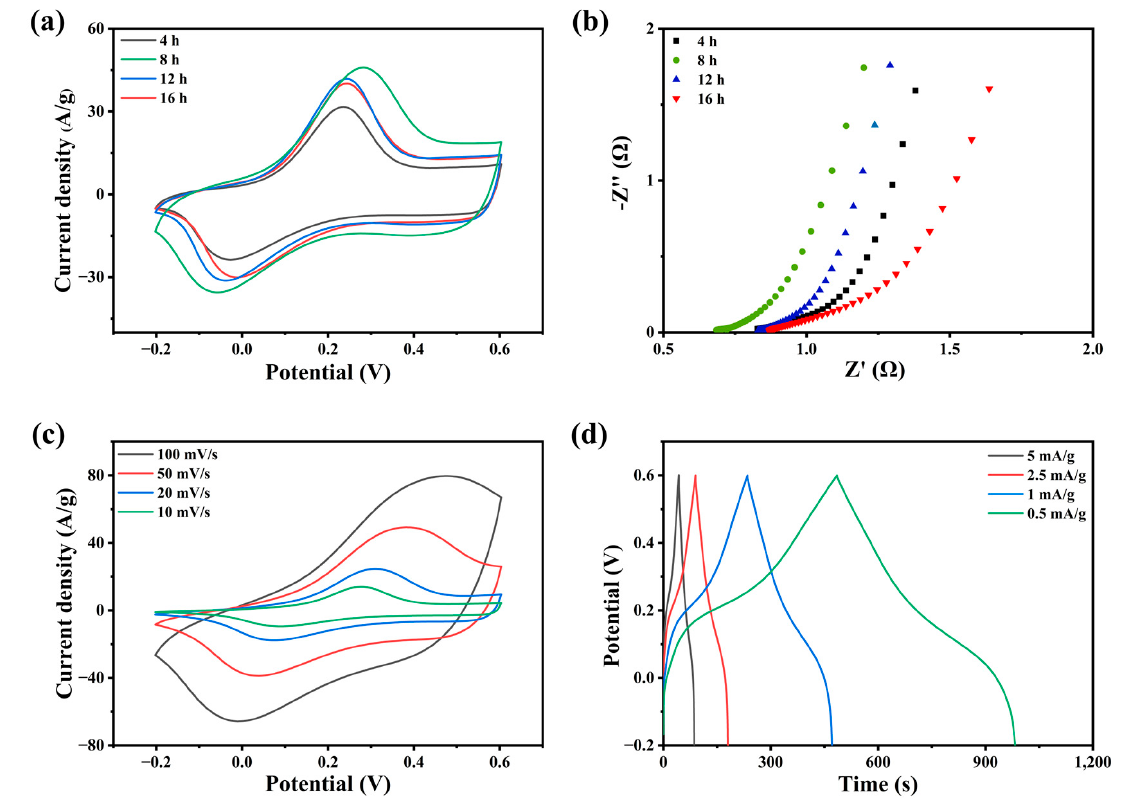
Figure 3. ( a ) CV curves of PANI/graphite paper electrodes with different polymerization times; ( b ) the Nyquist curves; ( c ) CV curves of PANI-8 electrode at different scanning rates; ( d ) GCD curves of PANI-8 electrode at different current densities.